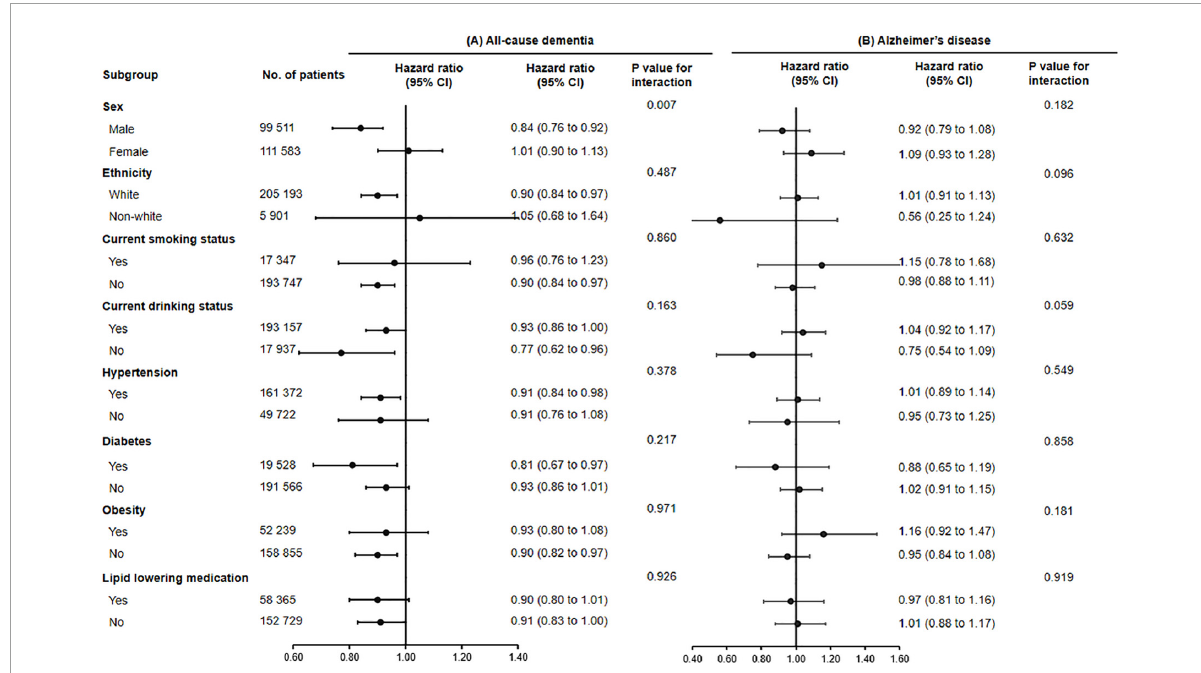
FIGURE1 The association of fish oil supplementation and the risk of all-cause dementia (A) and Alzheimer’s disease (B) in different subgroups. Results were adjusted for age, gender, ethnicity (white, black, Asian, Chinese, mixed, or other ethnic group), education level, smoking status (never, former, or current), alcohol consumption (never, former, or current), hypertension (yes or no), antihypertensive drug use (yes or no), aspirin use (yes or no), lipid lowering medication (yes or no), other vitamin or mineral or dietary supplementation (yes or no), Townsend Deprivation Index, household income [ < £18,000 (€21,489; $23,253), £18,000–£30,999, £31,000–£51,999, £52,000–£100,000, or > £100,000], physical activity ( < 150 or ≥ 150